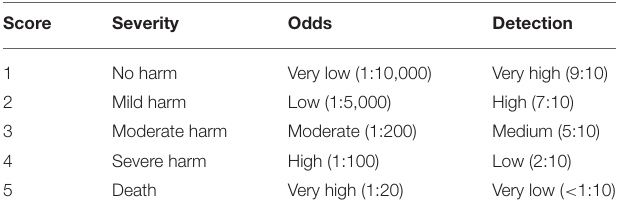
TABLE 1 | RPN variables and their labeling and relations to their scores.